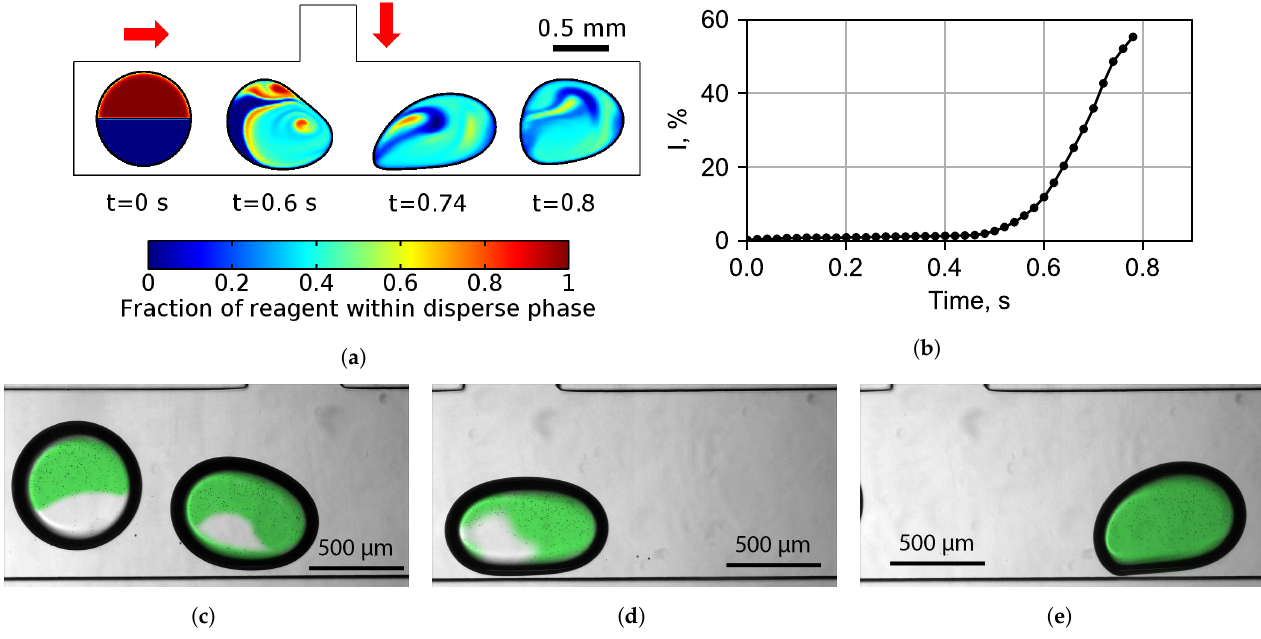
Figure 3. Reinjection of the droplet reactors in an asymmetric T-junction: ( a ) numerical simulations of the droplet flow near the side channel; ( b ) time dependence of the mixing index Equation (2); and ( c – e ) experimental verification in the chip. It can be seen that the polymer microparticles with a nominal diameter of 1 µ m in a droplet before the side channel were only located in the zone of the upper Taylor vortex, and after the reinjection, they were distributed over the entire volume of the droplet (flow direction from left to right). For better visualization, the area where the distance between the particles in the figure was less than 100 µ m was tinted with green using the ImageJ